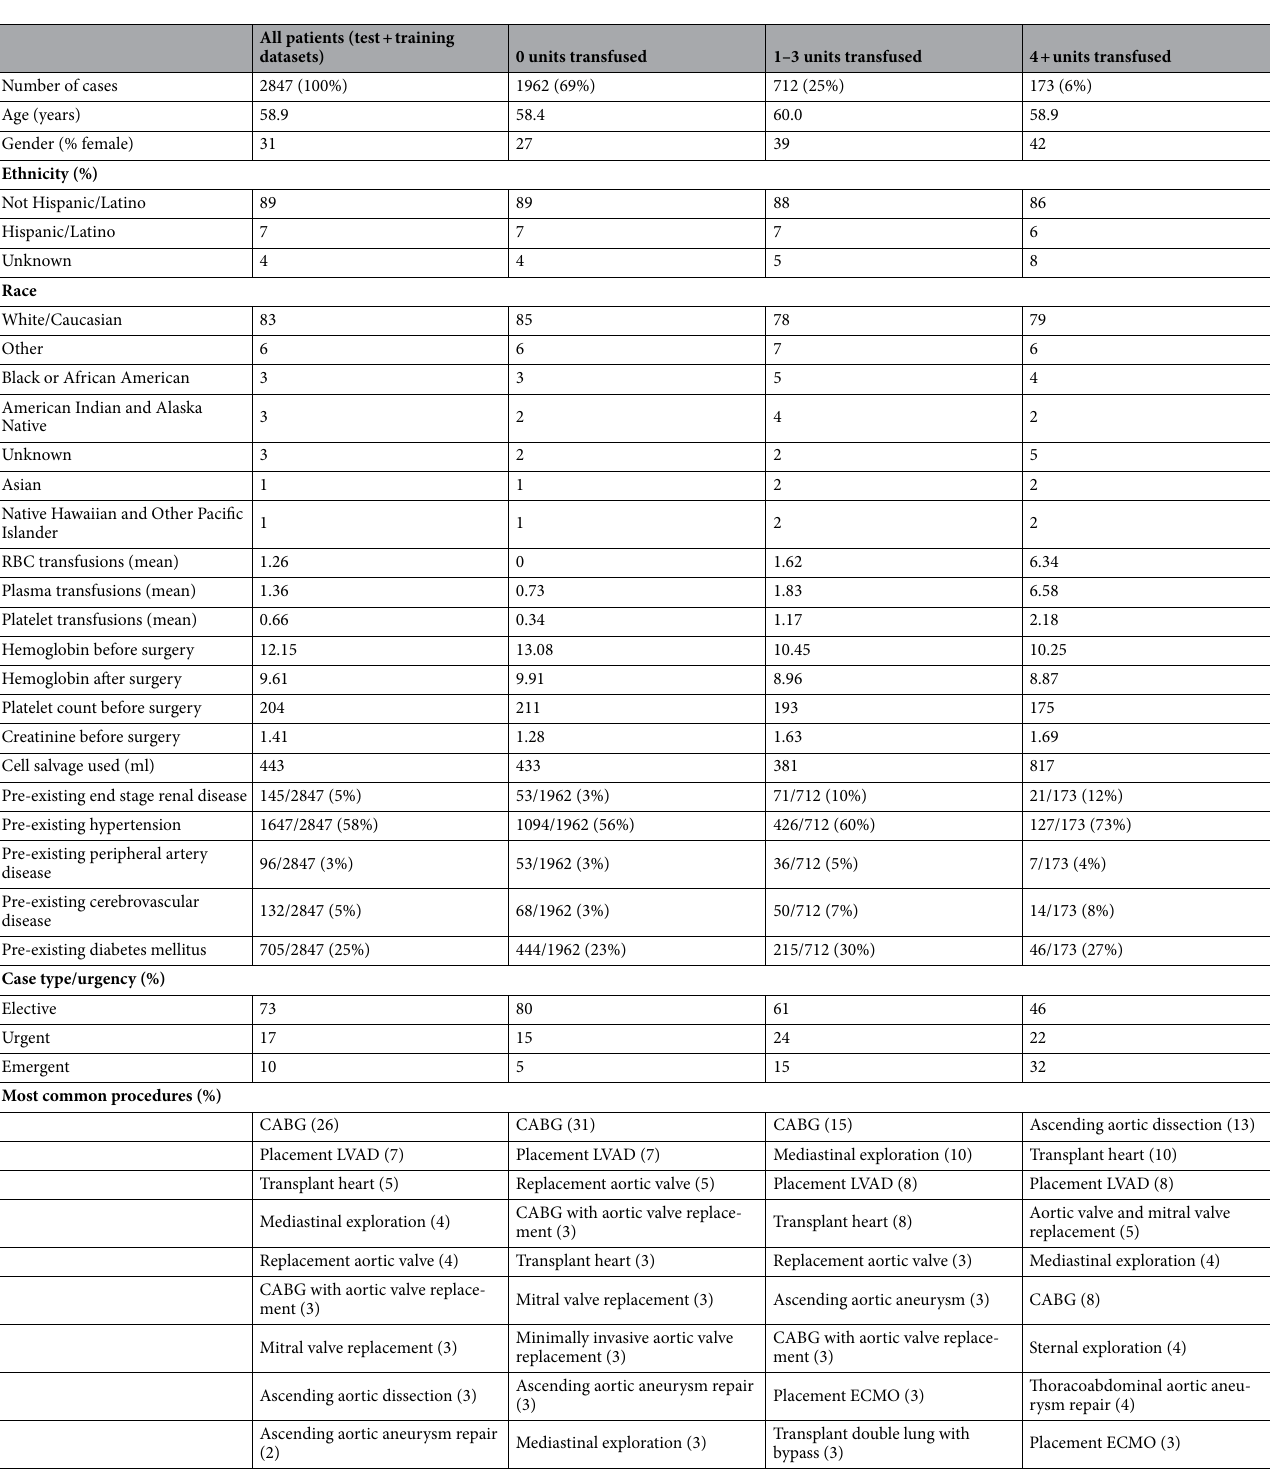
Table 1. Combined characteristics of cases in the training (development) and test (validation) datasets. CABG coronary artery bypass graft, LVAD left ventricular assist device, ECMO extracorporeal membrane